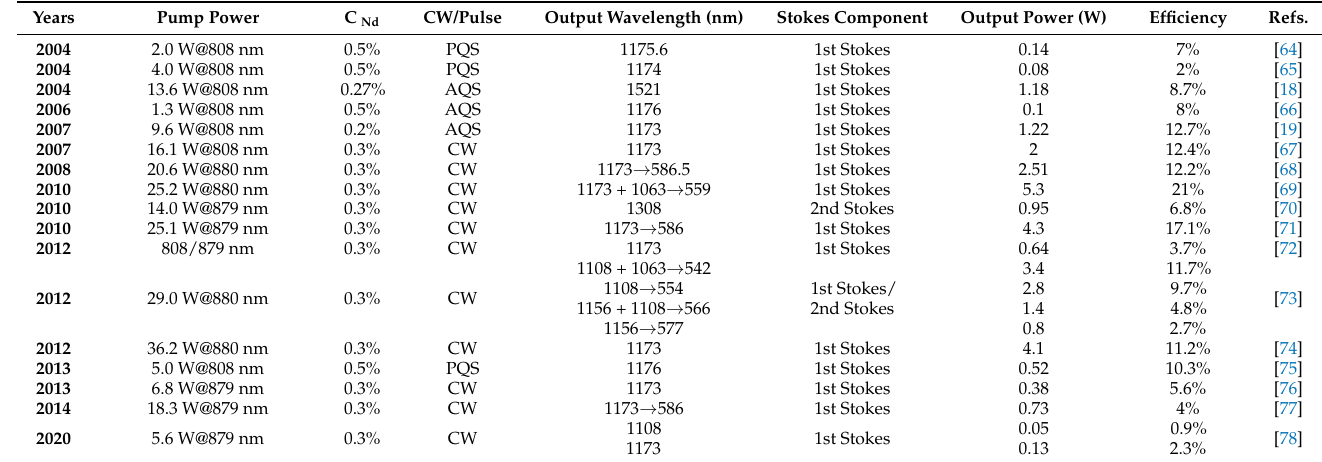
Table 4. Research progress on the Nd:GdVO 4 self-Raman lasers.